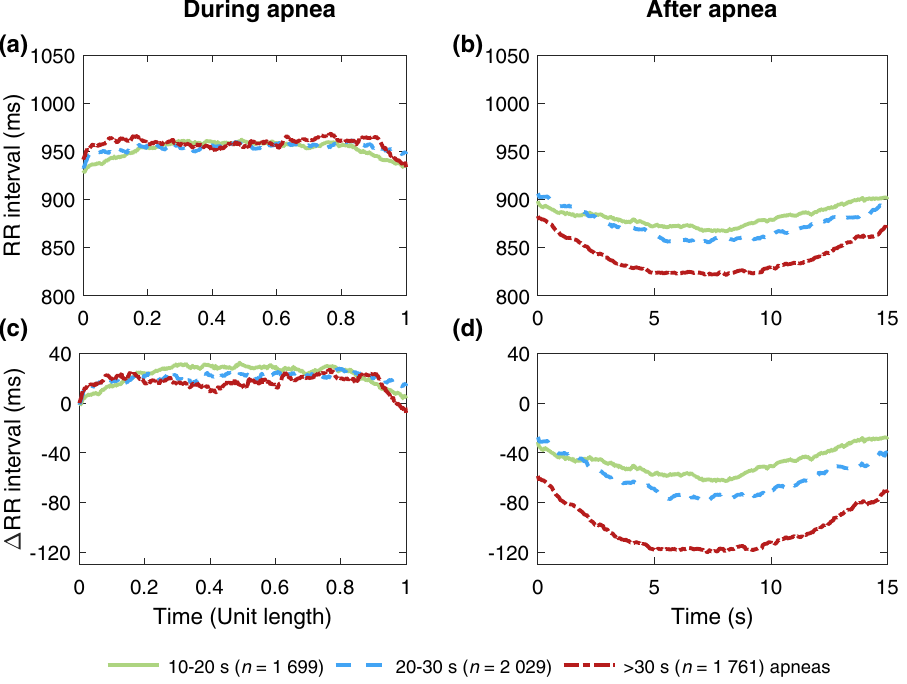
Figure 1. Median RR intervals of men ( n = 321) ( a) during apneas of different durations ( n = 5 489) and ( b) during a 15-s segment following apneas. The absolute change in RR intervals relative to the beginning of the event during and after apneas are presented in subfigures ( c) and ( d) , respectively. In subfigures ( a) and ( c) the duration of every apnea event is normalized with its duration.